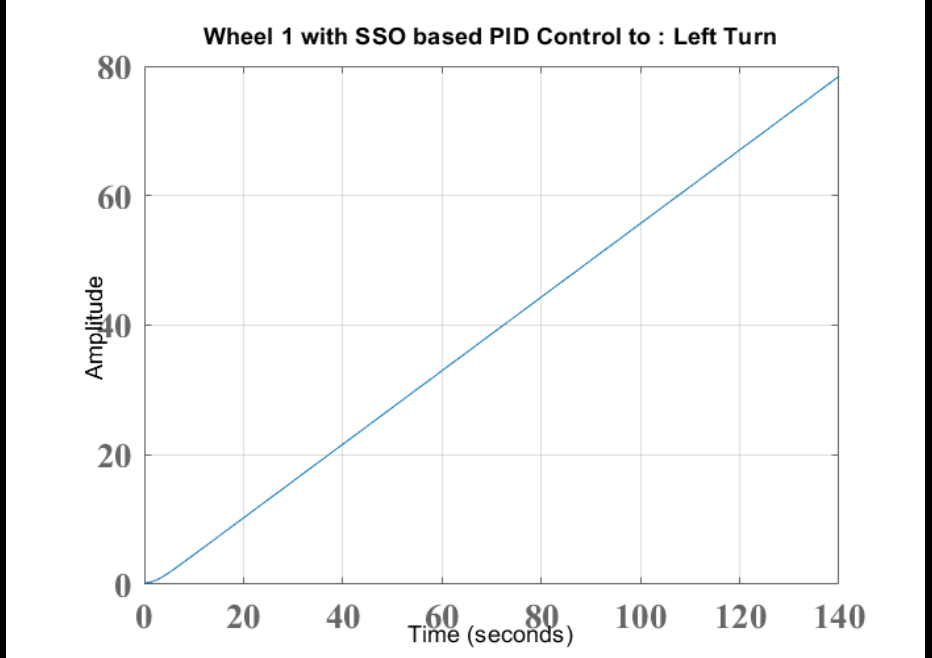
Figure 15. Simulation of wheel 1 turning left when V r < V L .